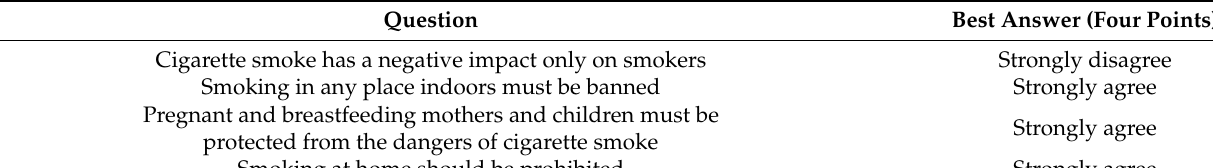
Table A2. Questions on the attitude, commitment, and